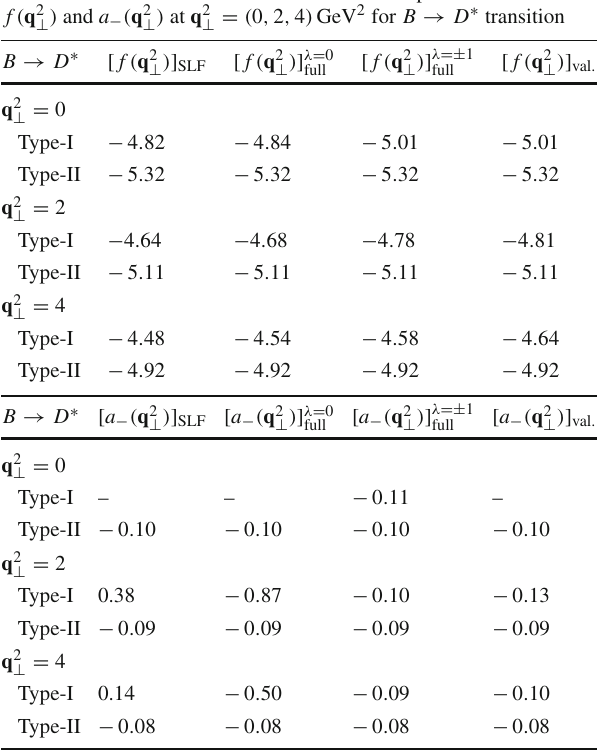
Table 2 Numerical results of the zero-mode dependent form factors f ( q 2 ⊥ ) and a − ( q 2 ⊥ ) at q 2 ⊥ = ( 0 , 2 , 4 ) GeV 2 for B → D ∗ transition B → D